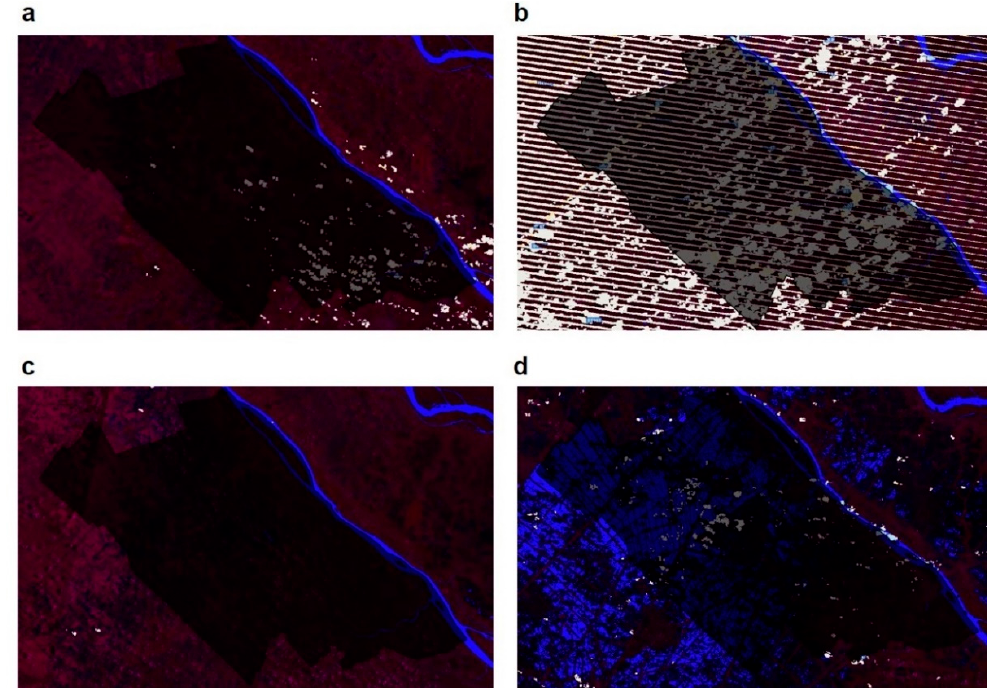
Figure 5. False color Landsat imagery showing the study area during ( a ) cloud cover ( b ) scan line collector failure ( c ) dry season ( d ) flood season.